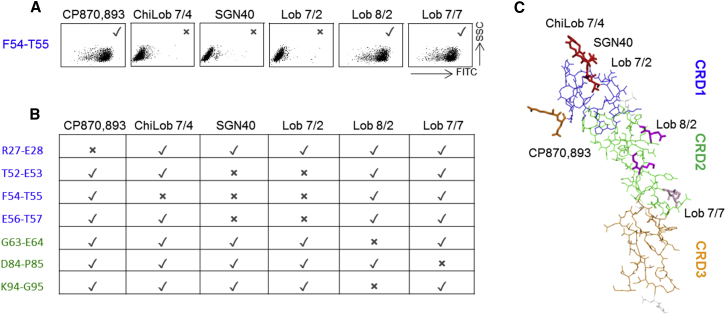
Alanine Scanning Epitope Mapping of Anti-hCD40 mAbsCHO-k1 cells stably expressing mutant hCD40 proteins were incubated with the indicated m1 mAb and binding detected by flow cytometry with anti-mouse Fc-FITC.(A) Example plots for the F54-T55 mutant to illustrate positive (tick) and negative (cross) binding results.(B) Summary of data for additional hCD40 mutants (at least two experiments per combination).(C) Deduced mAb epitopes are illustrated on the hCD40 crystal structure resolved in Figure 2, and are color coded with those for ChiLob 7/4, SGN40, and Lob 7/2 overlapping. See also Figure S2.